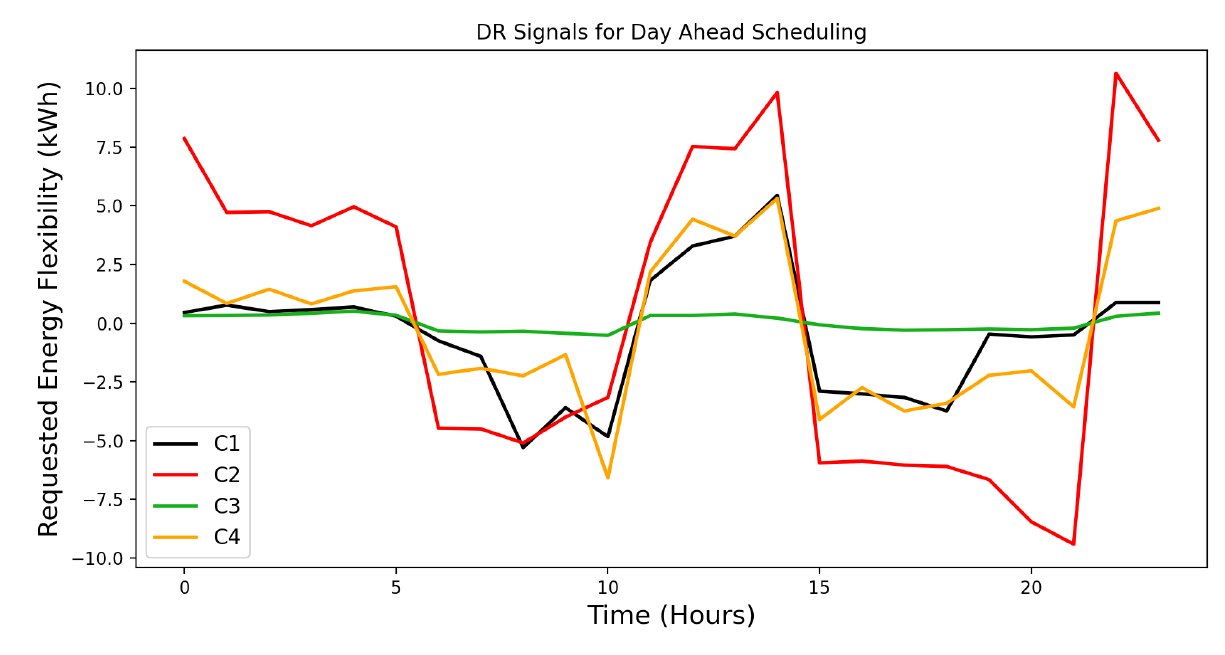
Figure 8. DR Signals sent to consumers C1, C2, C3 and C4. Table 2. Portfolio savings for a week (1 February 2019 up to 7 February